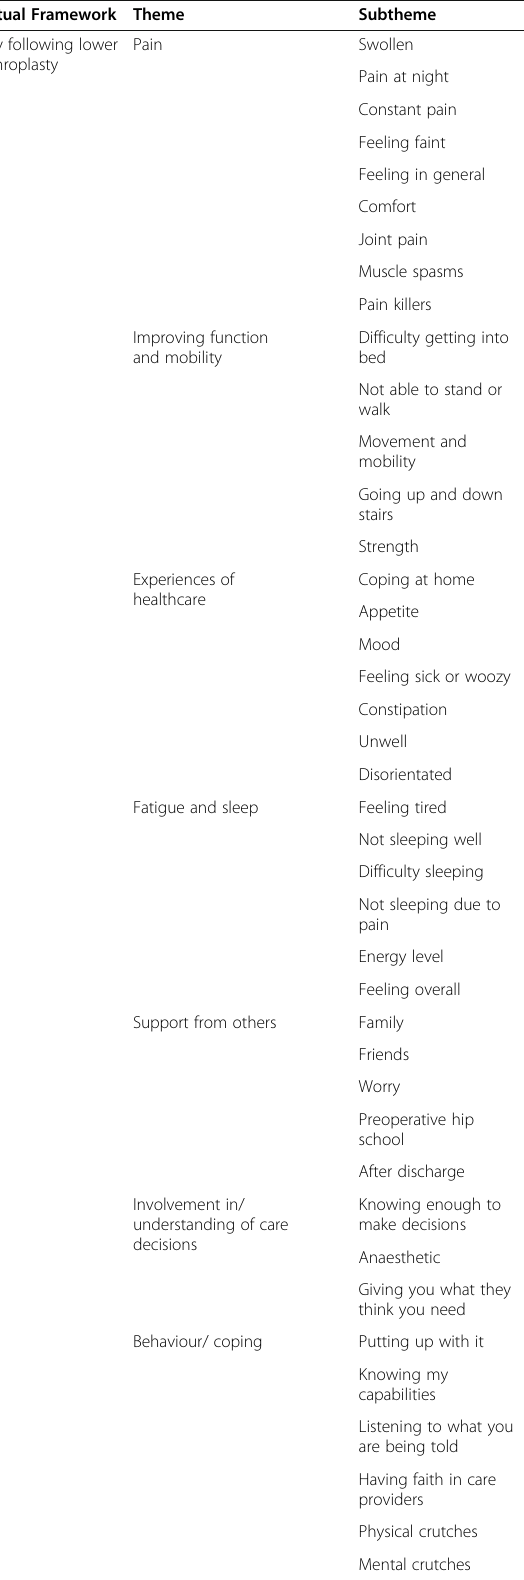
Table 3 Conceptual framework Conceptual Framework Theme Recovery following lower limb